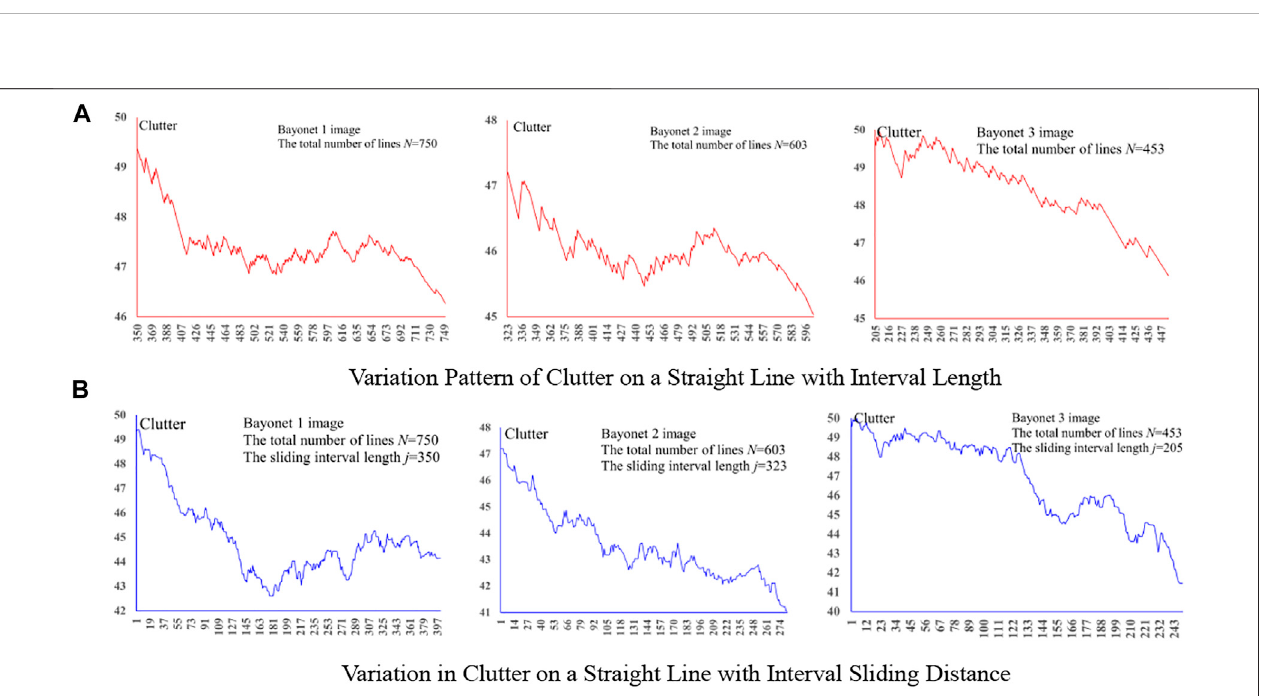
FIGURE3| Variationpatternofclutteronthestraightline. (A) Variationpatternofclutteronastraightlinewithintervallength. (B) Variationinclutteronastraightline with interval sliding distance.